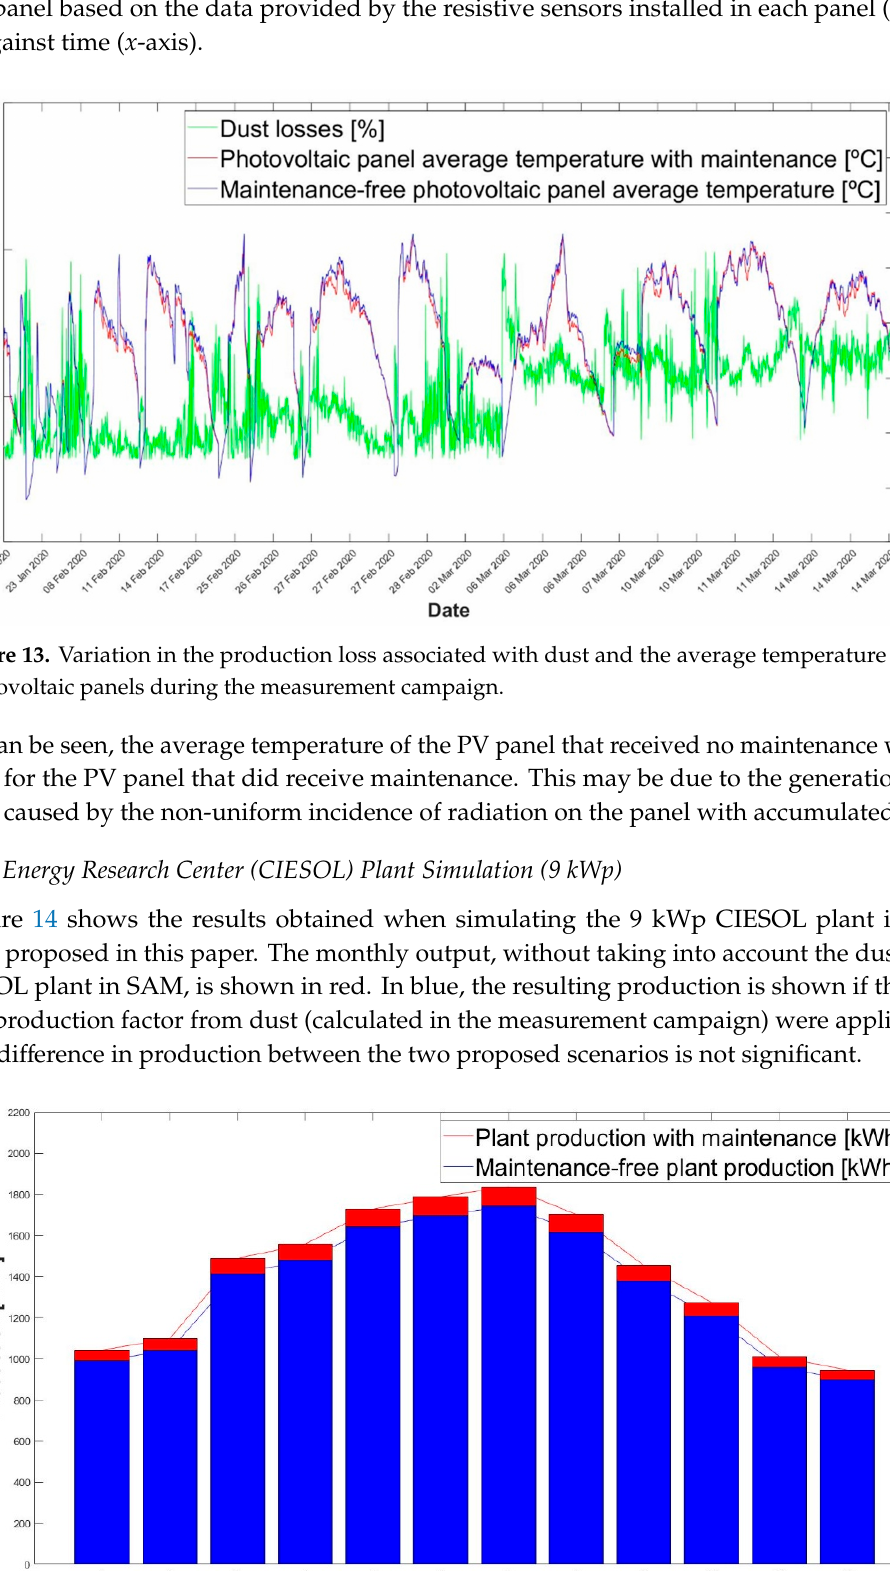
Table 5. CIESOL plant income (9 kWp), clean and dirty. Month